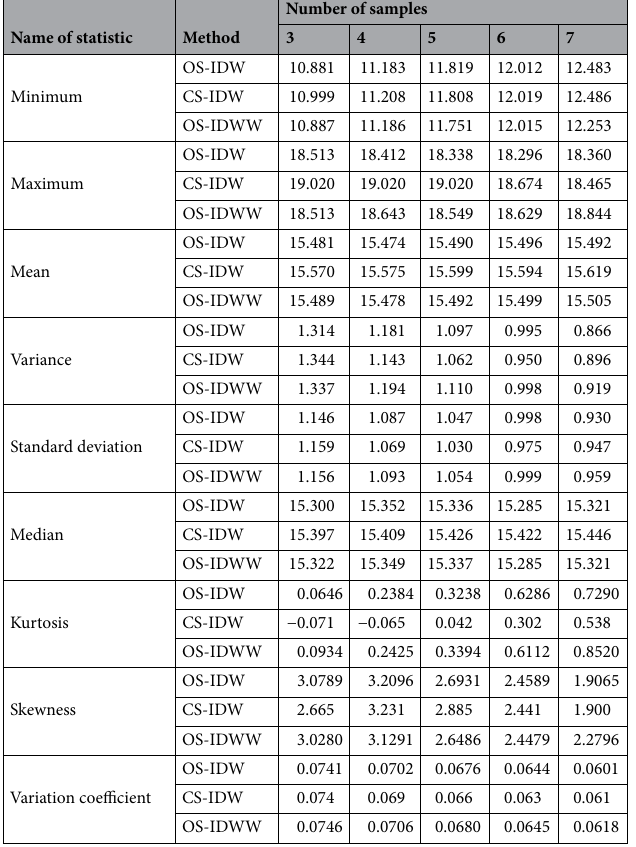
Table 3. Statistics of the Al grade estimation